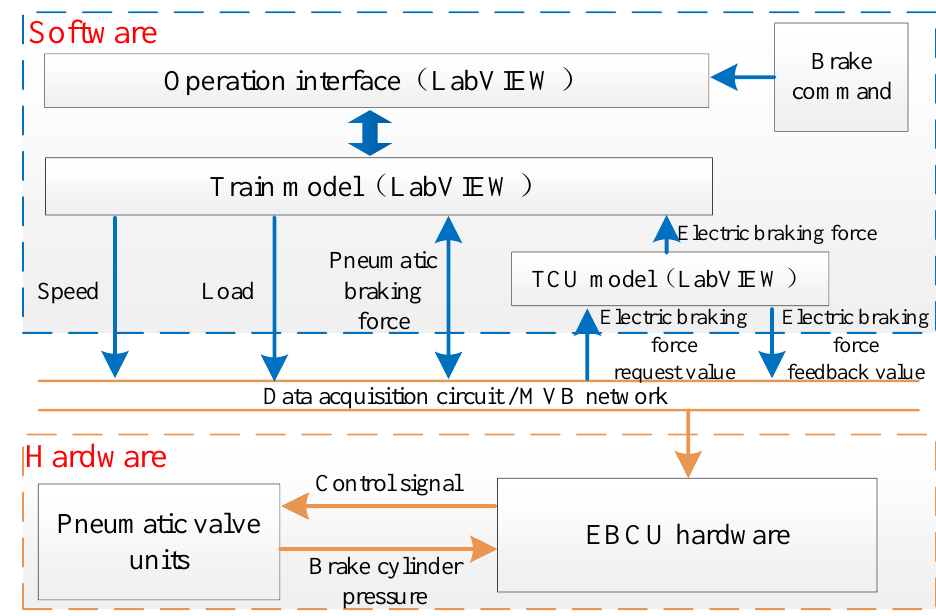
Figure 8. Software and hardware communication topology.